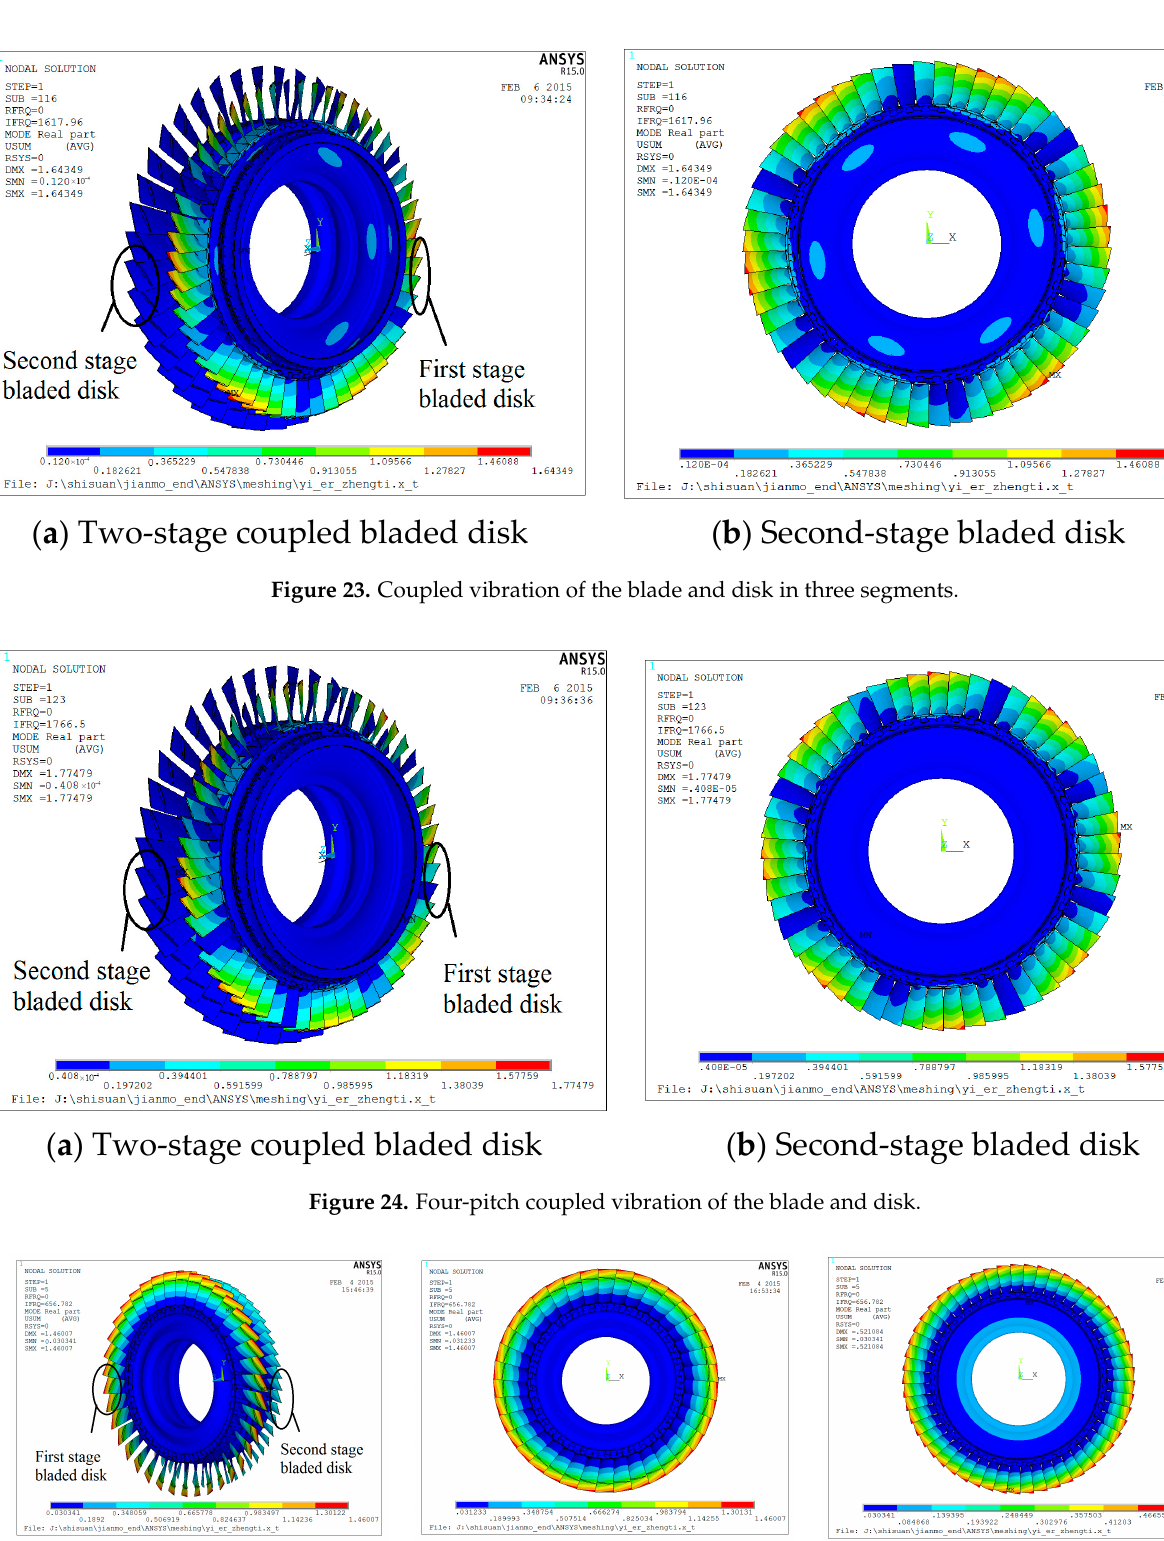
Figure 22. Coupled vibration of the blade and disk with a two-pitch diameter.